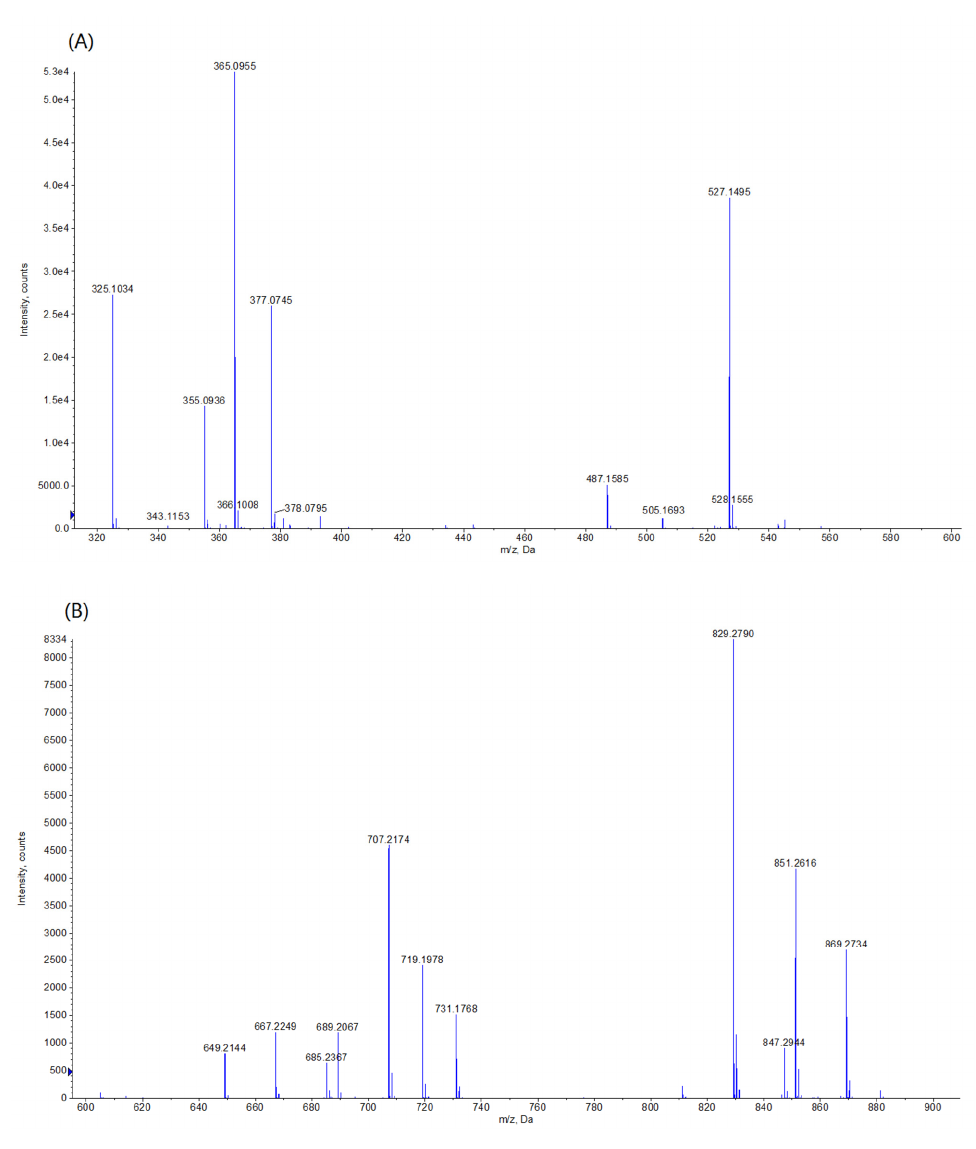
Figure 2. ESI-TOF-MS spectra of the CGA-rice complex sample. ( A ) m / z range of 300–600 Da; ( B ) m / z range of 600–900 Da.